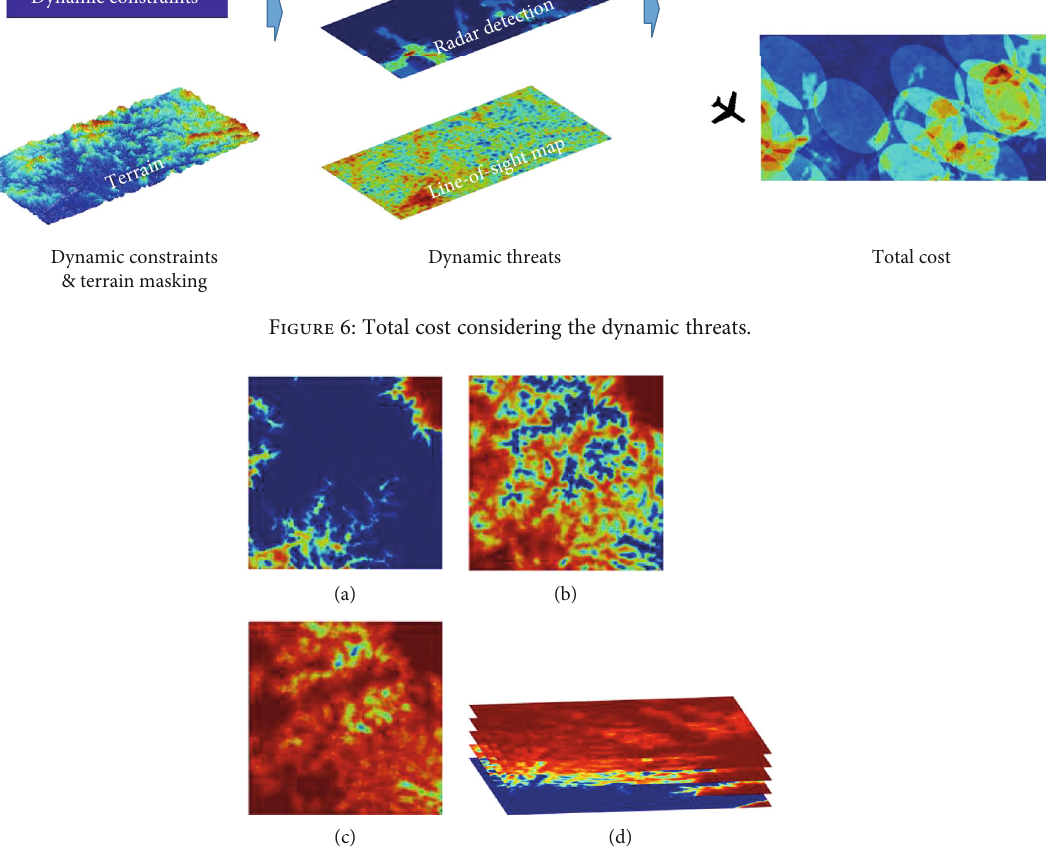
Figure 7: The LOS map according to the altitudes: (a) the altitude of 500m; (b) the altitude of 1000 m; (c) the altitude of 1500 m; (d) a stack of LOS maps used for the LOS